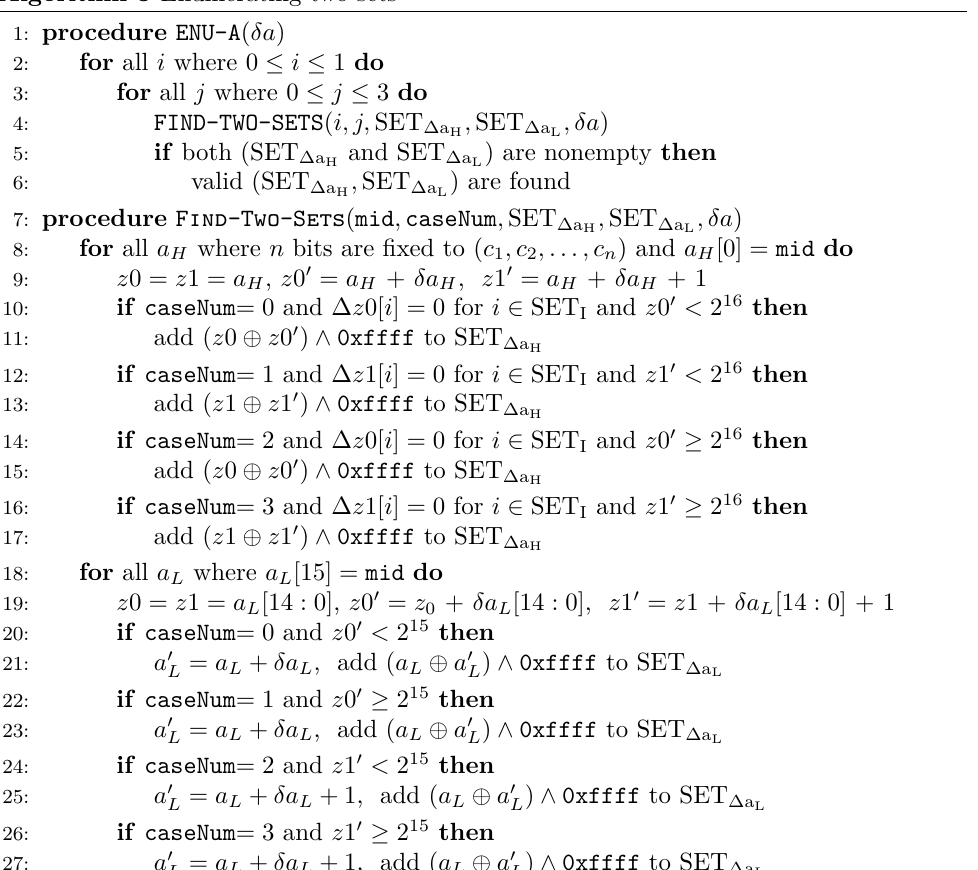
Algorithm 3 Enumerating two